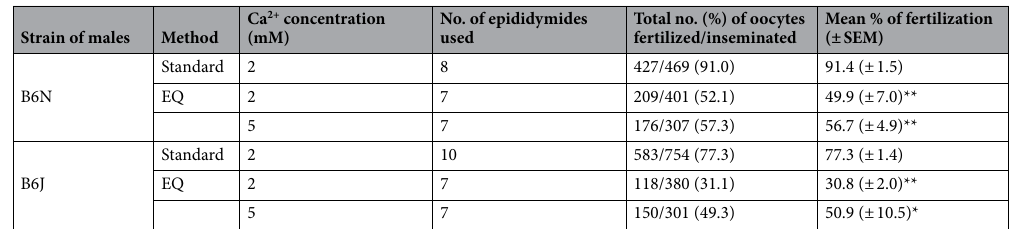
Table 1. Fertilization rates of oocytes following IVF using spermatozoa frozen by the standard or EQ methods. ** P < 0.01, * P < 0.05 vs standard cryopreservation method for the same strain by Mann–Whitney nonparametric U test. SEM, standard error of the